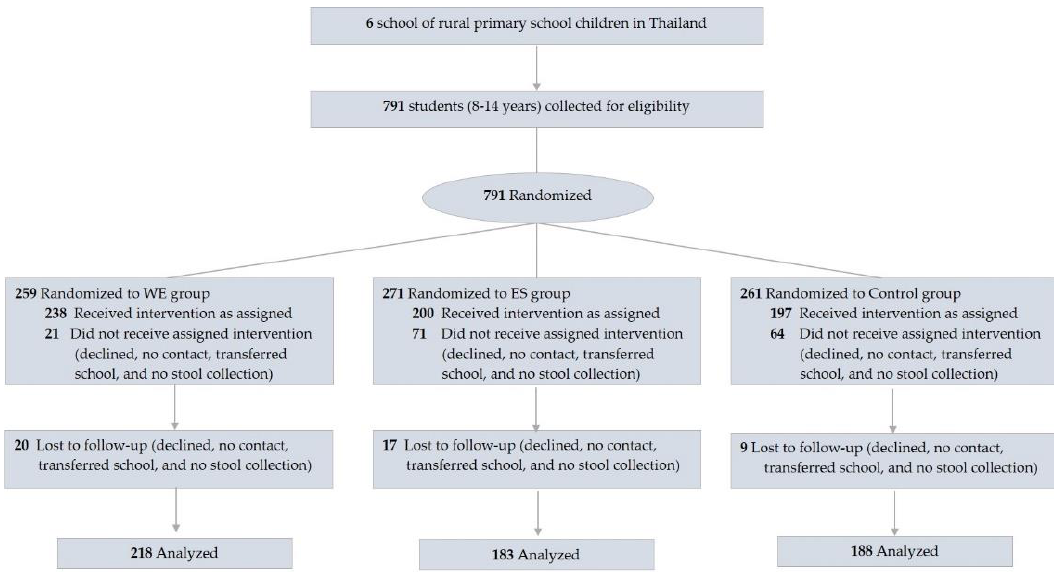
Figure 1. Flow diagram of participants. Abbreviations; WE = whole egg group; PS = protein substitute group.